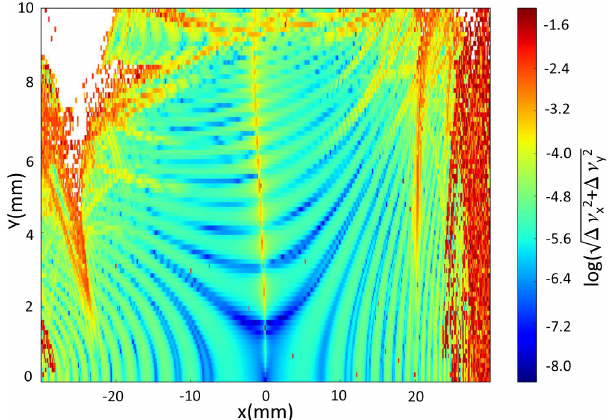
FIG. 12. Frequency diagram for lattice nsls2sr_supercell_ch77.